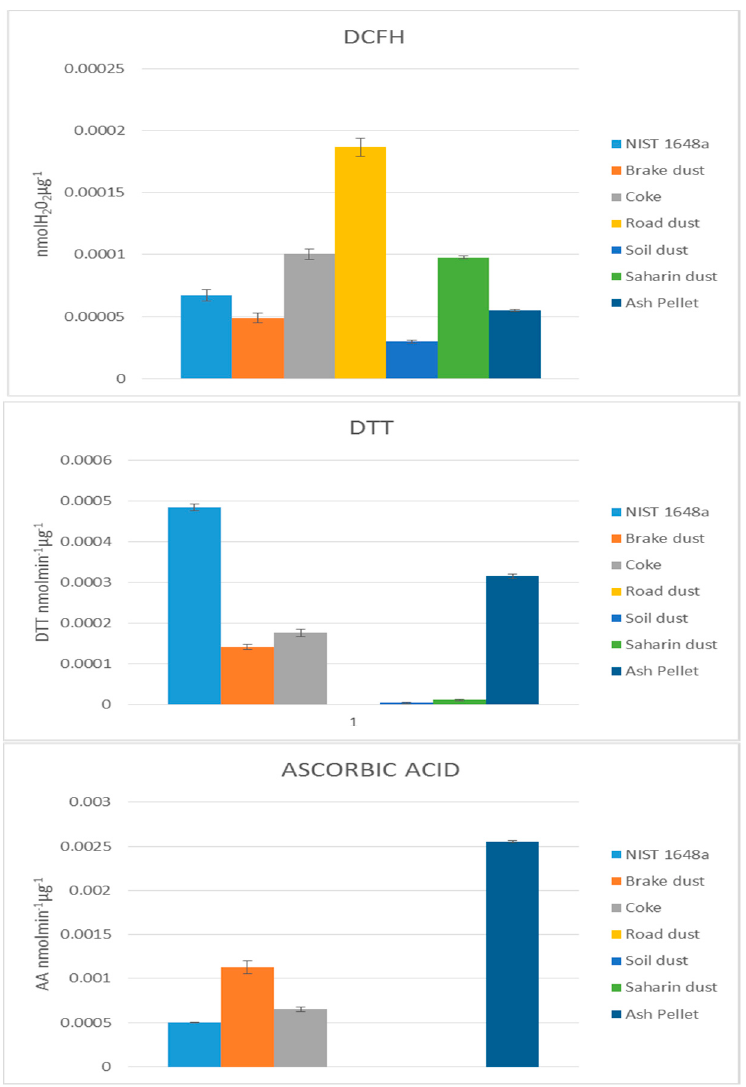
Figure 1. Oxidative potential analysis of soluble part with DCFH, DTT and AA